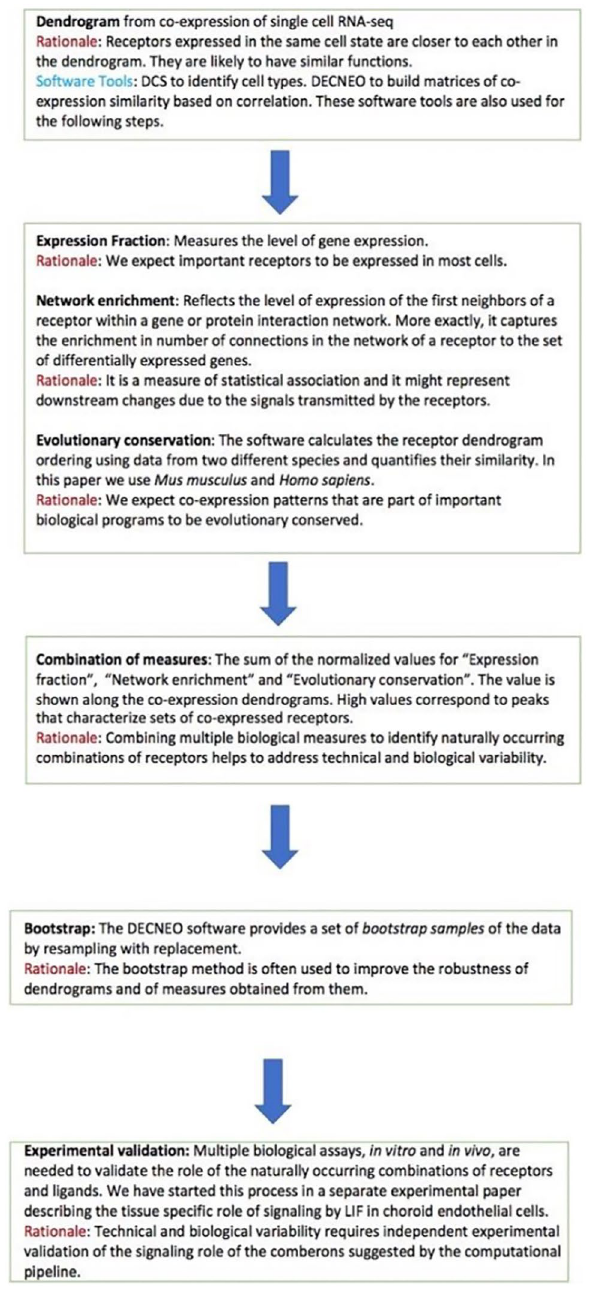
Figure 1. Flowchart with details and rationale of the main steps followed by our process. Additional features not mentioned in the flowchart are: Visualization: As shown in Fig. 2, the DECNEO software provides visualizations of the dendrogram and panels that plot the measures described above. It also highlights the location in the dendrogram of the known angiogenesis receptors and allows users to inspect individual measures and to identify cases when they are not concordant. Statistical analysis and validation: Multiple validations and statistical tests are performed, including a permutation test, validations with independent datasets, the use of a set of receptors with known function (which includes VEGF receptors and other receptors previously shown to play a role in angiogenesis) and interface with other common functional enrichment methods using DAVID and Metascape. Application to intercellular communication: An extension of the method, shown in Fig. 5, can be used to analyze ligands and receptor for a pair of cells. Further evidence for the functional importance of naturally occurring combinations of receptors is obtained by identifying the corresponding naturally occurring combinations of